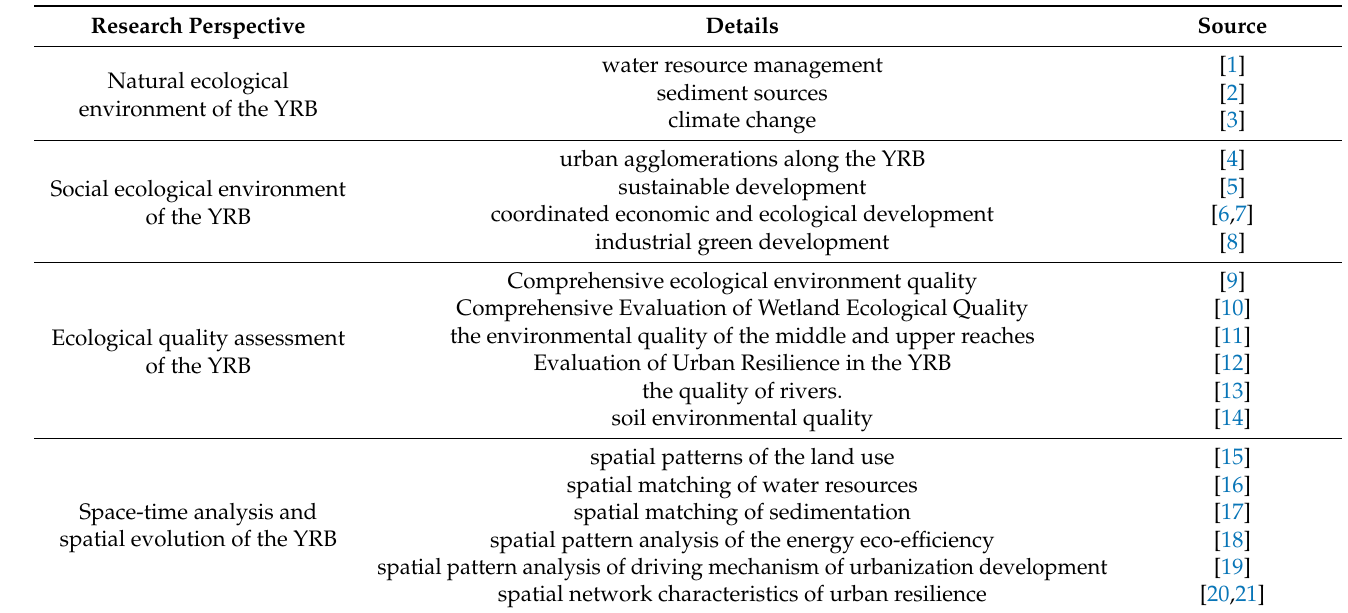
Table 1. Literature review of the UECC in the